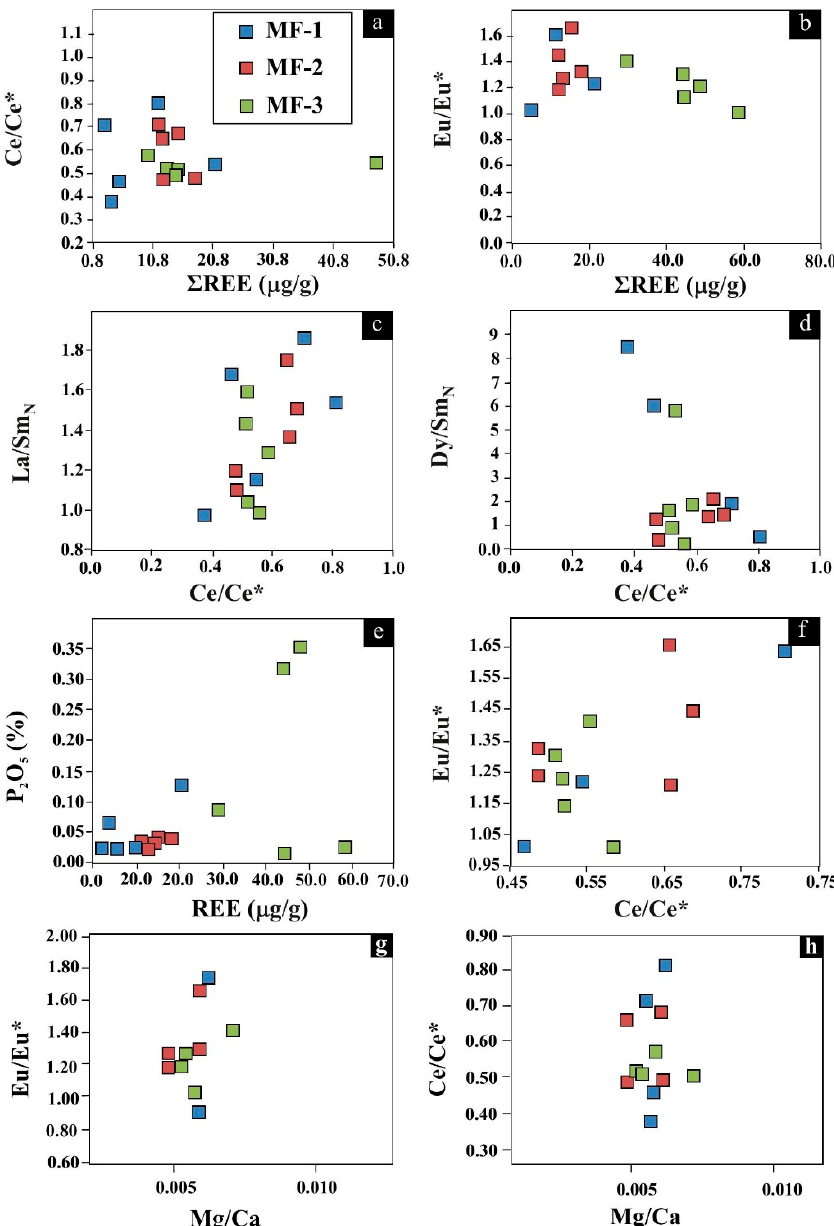
Figure 8. Plots of the Σ REE (µg/g) contents vs. Ce/Ce* ratios ( a ); Σ REE (µg/g) contents vs. Eu/Eu* ratios ( b ); Ce/Ce* vs. La/Sm N ratios ( c ); Ce/Ce* vs. Dy/Sm N ratios ( d ); Σ REE (µg/g) vs. P 2 O 5 (wt %) contents ( e ); Eu/Eu* vs. Ce/Ce* ratios ( f ); Mg/Ca vs Eu/Eu* ( g ) and Mg/Ca vs. Ce/Ce* ratios ( h ).